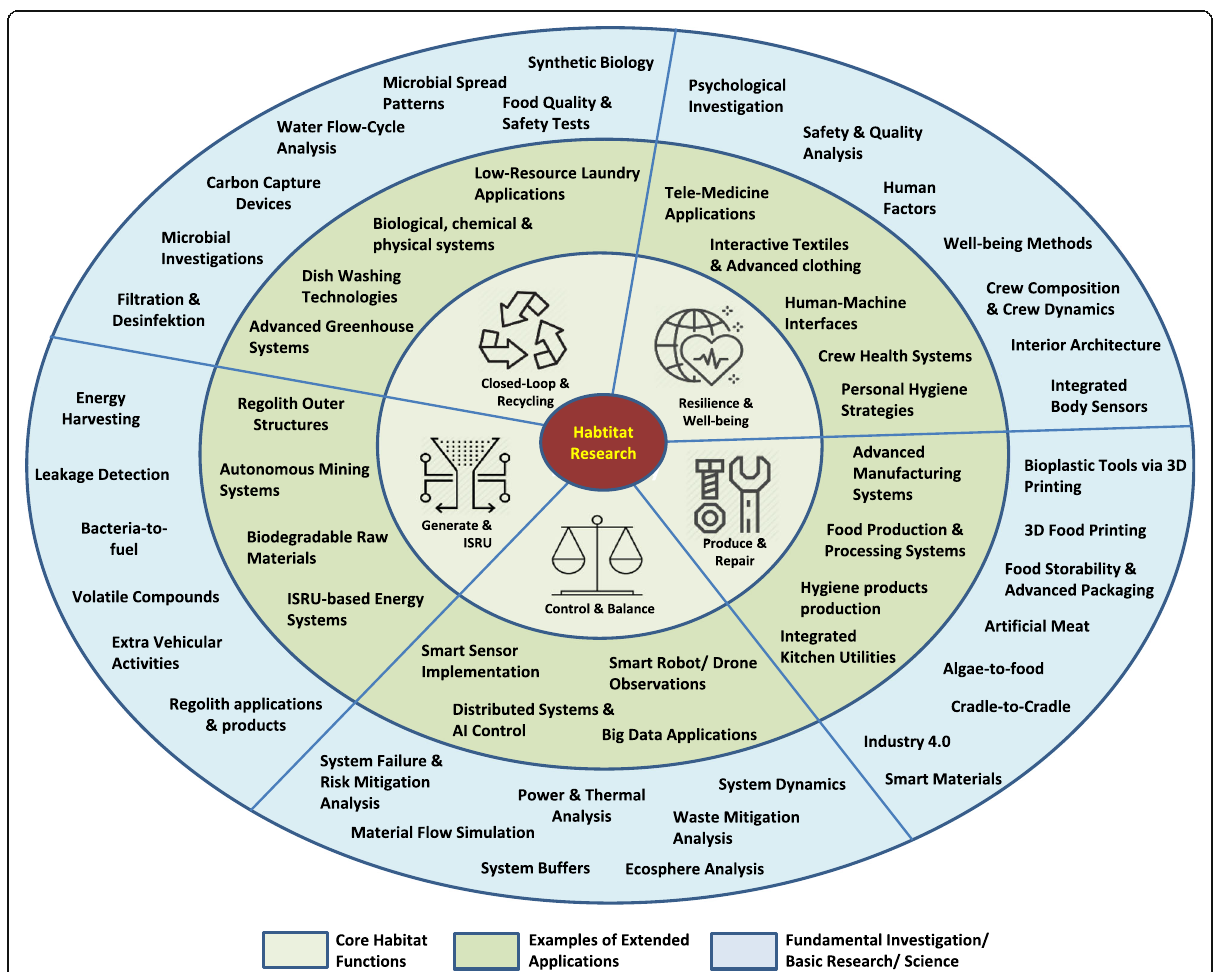
Fig. 3 Domains in habitat research bases on basic functions (light green), examples of adjoining products and methods (green), and fundamental research